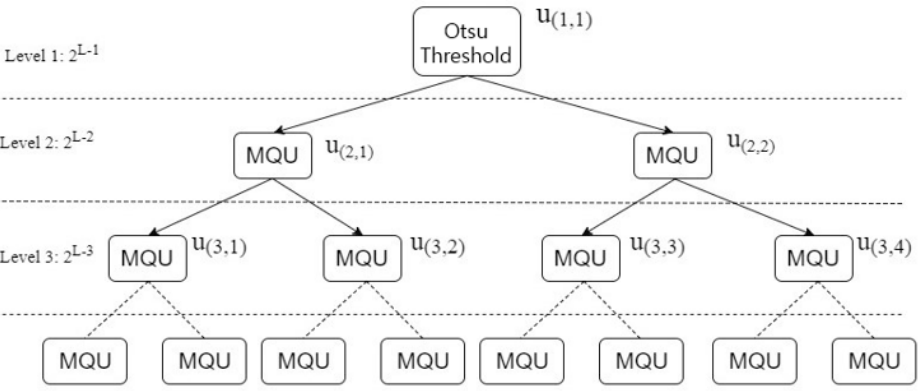
Figure 2. The SMQT as a binary tree of the mean quantization unit (MQU).